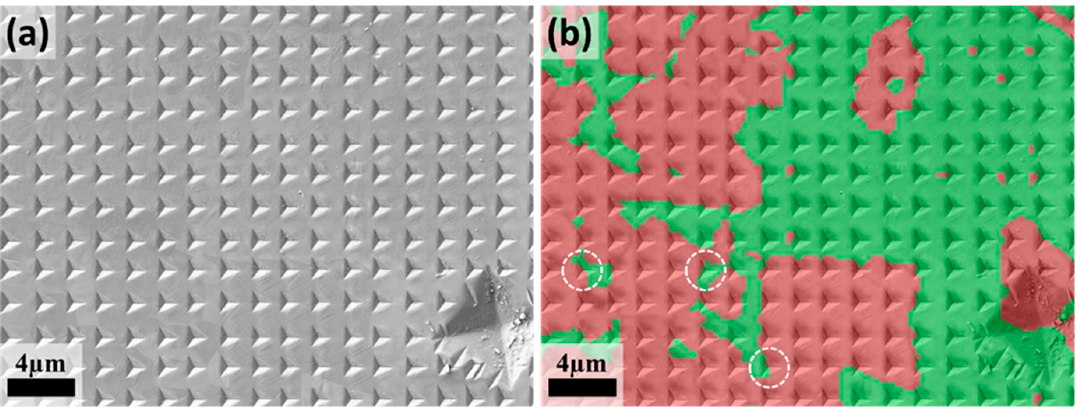
Figure 6. ( a ) Field emission scanning electron microscope (FESEM) micrograph of a region of the indented surface. ( b ) Phase map of the same region overlaid with the original micrograph.